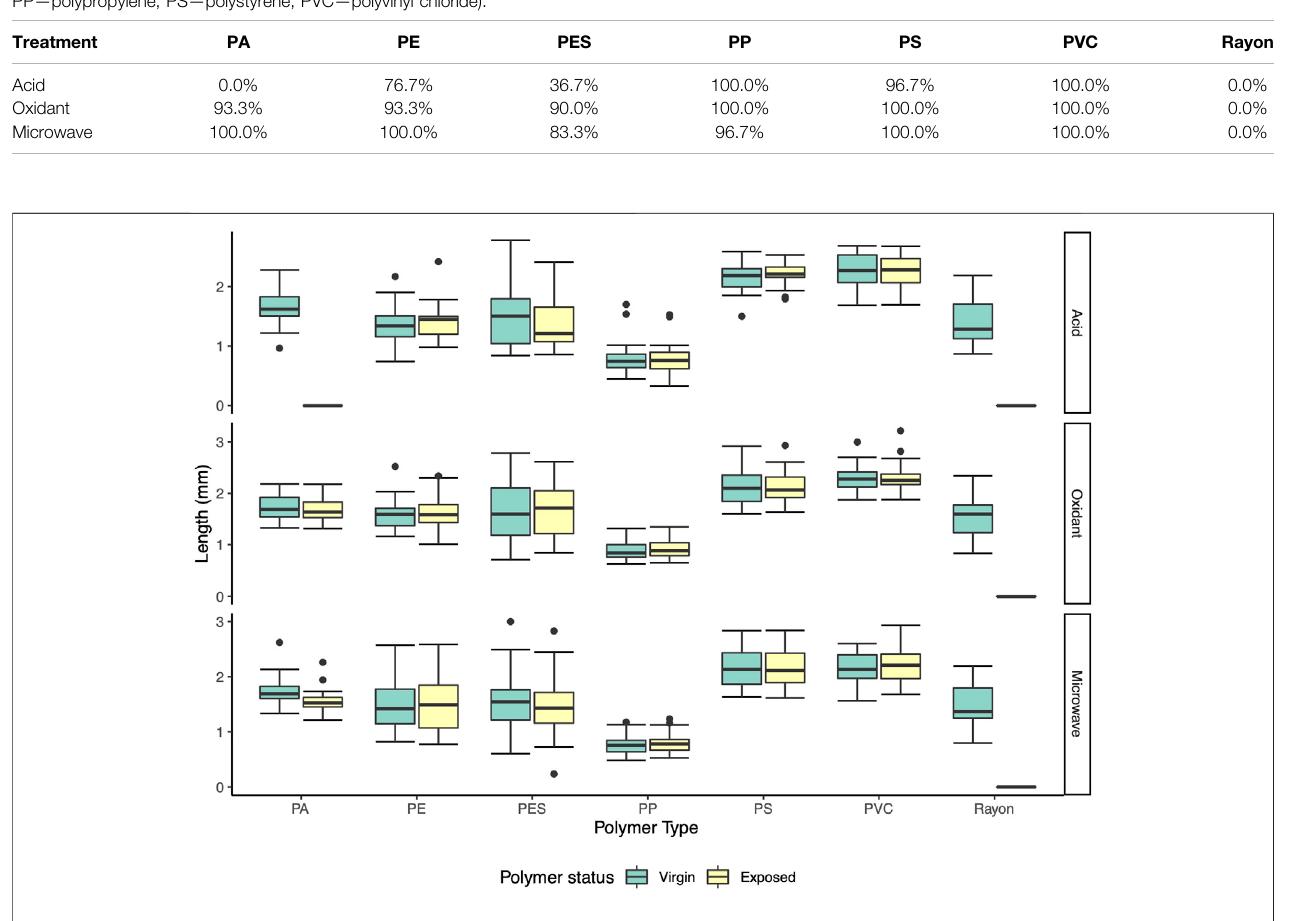
Frontiers in Environmental Chemistry |